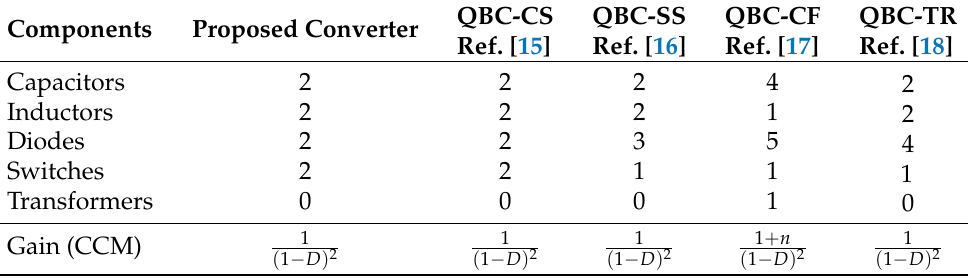
Table 1. Comparison of the proposed converter with other quadratic